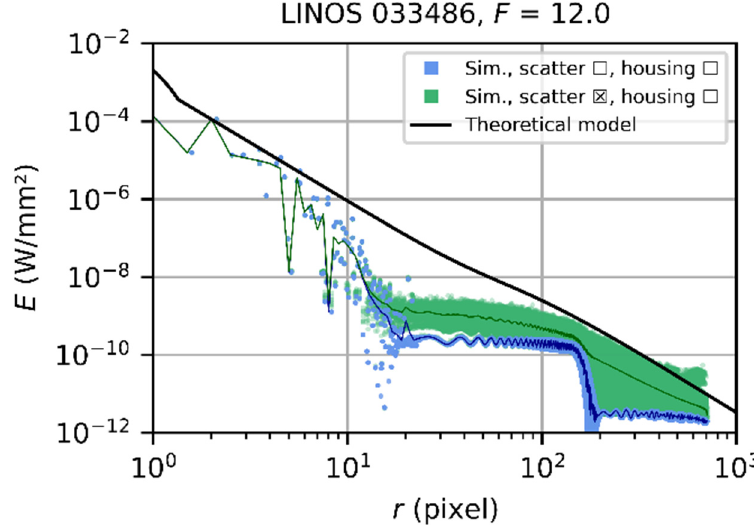
Figure 10. Scatter plot of simulated irradiance values for all detector pixels versus their radial distance to the center of the simulated laser spot for the LINOS 033486 lens and an f-number F = 12. Set 1 of simulation settings was applied.